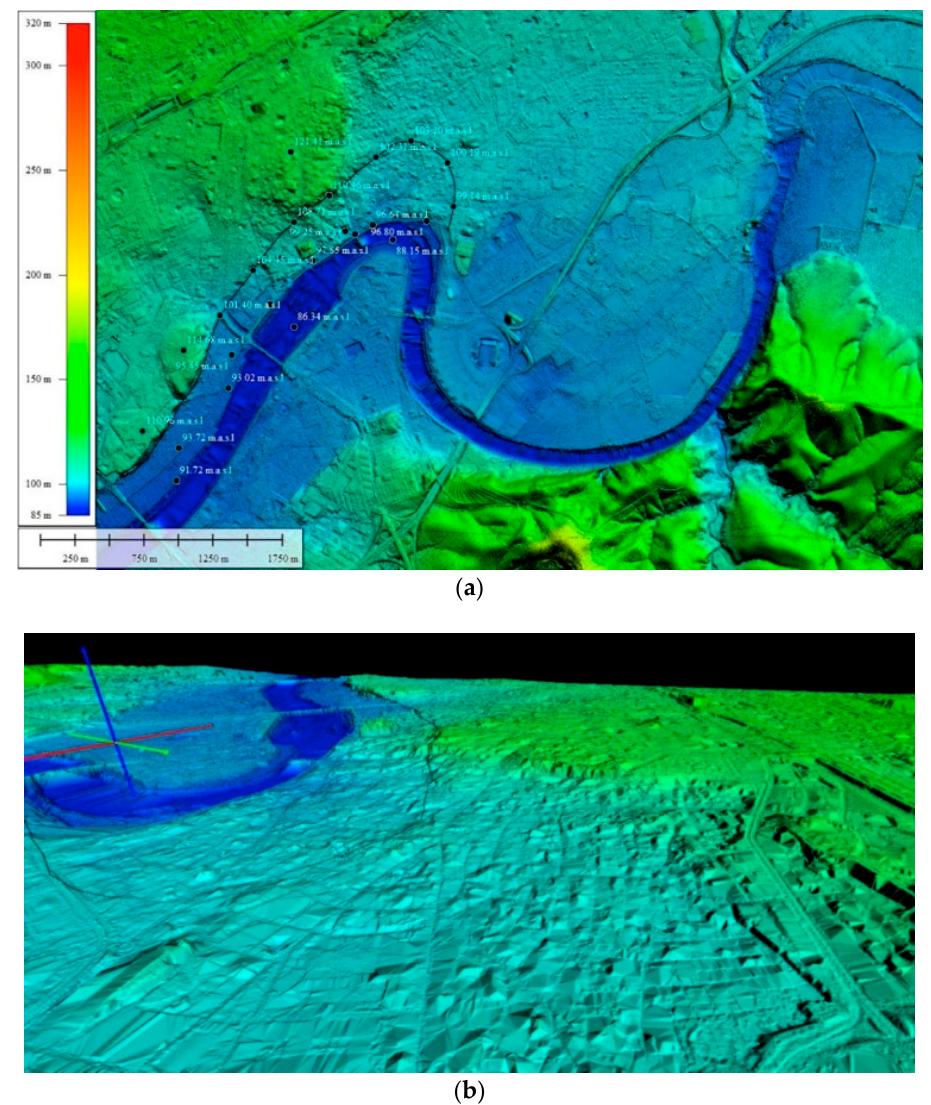
Figure 6. ( a, b ) : A. Elevations, slopes and layout of the ancient paleo channel and the hypothetical paleo meander of the Guadalquivir River. B. 3D model (vertical exaggeration: 2.75). The building that stands out in the ancient paleo riverbed of the Guadalquivir is the Great Mosque of Cordoba (S.X a. C). It is not available to delete the LiDAR points from the general point cloud acquired by PNOA-LIDAR. DSM generated from LAS files. The ©PNOA-LiDAR 2016 CC-BY 4.0 ign.es files were processed with the Global Mapper 18.1 colour ramp shader hillshade and the 3D model was developed by Antonio Monterroso-Checa. Coordinates in the central axis of the image: 37°51´40´´, 4°49´00”.